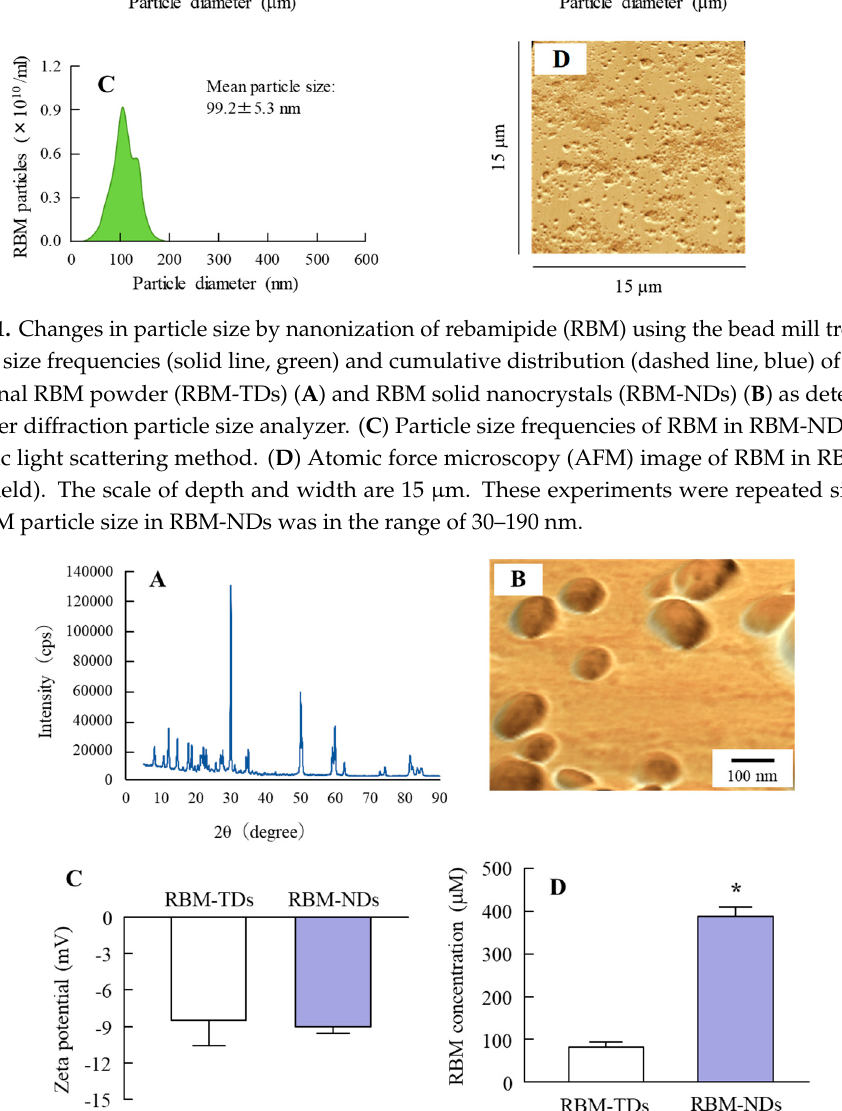
Figure 2. Morphology and particle characteristics of RBM in RBM-NDs. ( A ) XRD pattern of RBM treated with a bead mill. ( B ) AFM image of RBM in RBM-NDs. ( C ) Zeta potential of RBM in RBM-NDs. ( D ) Solubility of RBM in RBM-NDs. n = 6, * p > 0.05 vs. RBM-TDs. The RBM remained in the crystal form after treatment with the bead mill, and the form was spherical. The solubility of RBM was increased by bead mill treatment, and the content of dissolved RBM in RBM-NDs was 4.7-fold higher than in RBM-TDs. On the other hand, there was no difference in the zeta potential between RBM-TDs and RBM-NDs.